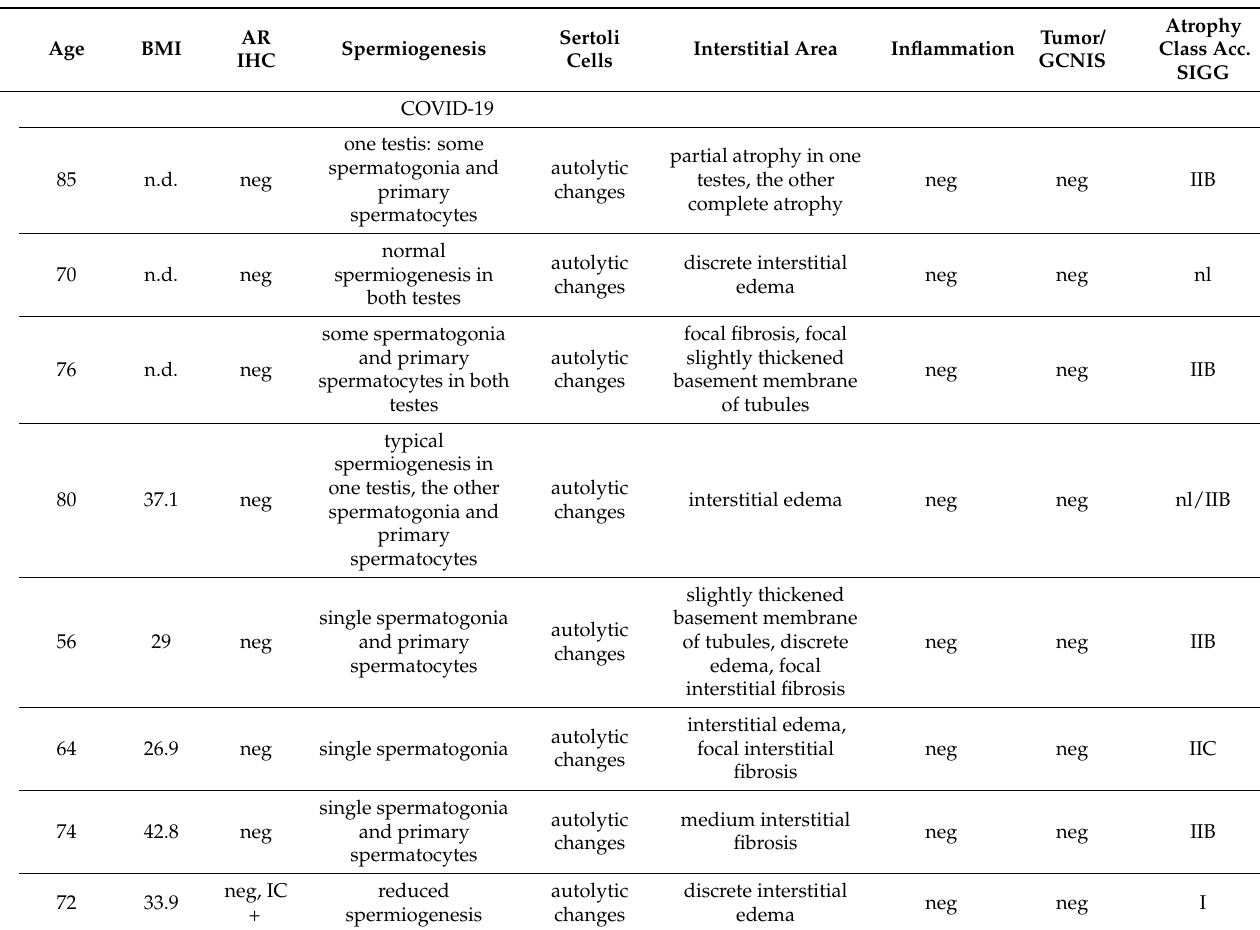
Table 2. Patient characteristic. Abbreviations: n.d. = not determined, neg = negative, IC =